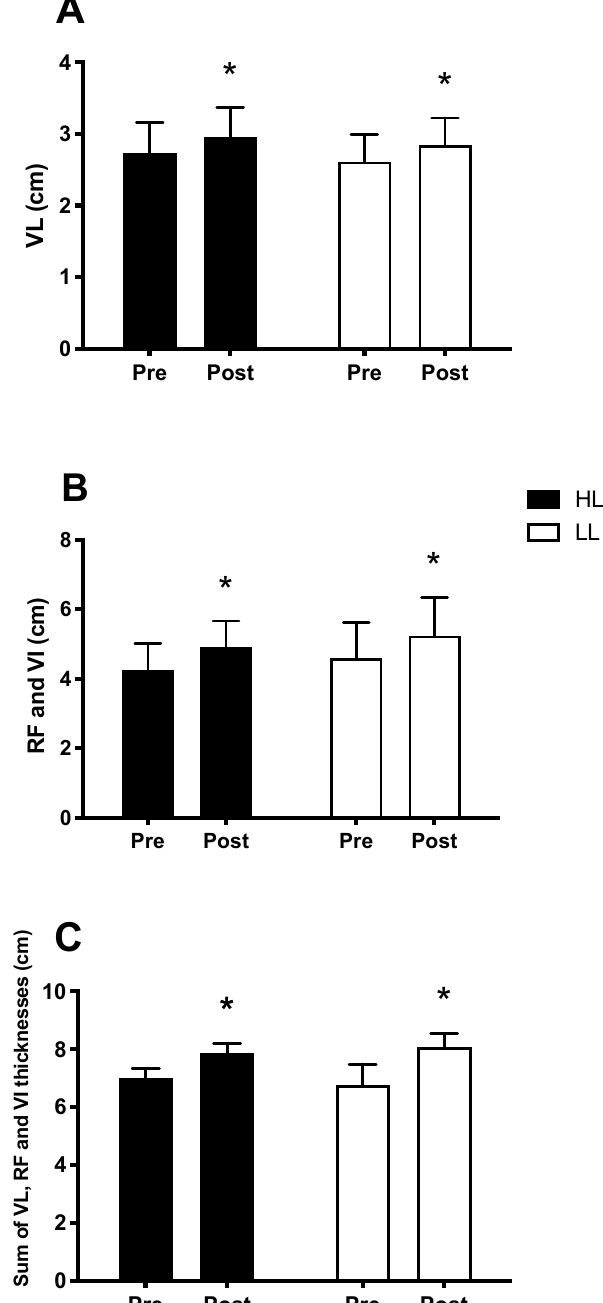
Figure 5. Thickness of the vastus lateralis muscle (VL) ( A ); sum of the thickness of the rectus femoris (RF) and vastus intermedius muscles (VI) ( B ); sum of the thickness of the vastus lateralis, rectus femoris and vastus intermedius muscles ( C ); Pre: before the training period, Post: after eight weeks of training. HL: High-load resistance training, LL: low-load resistance training. * p < 0.05 compared with the Pre intra-group period.